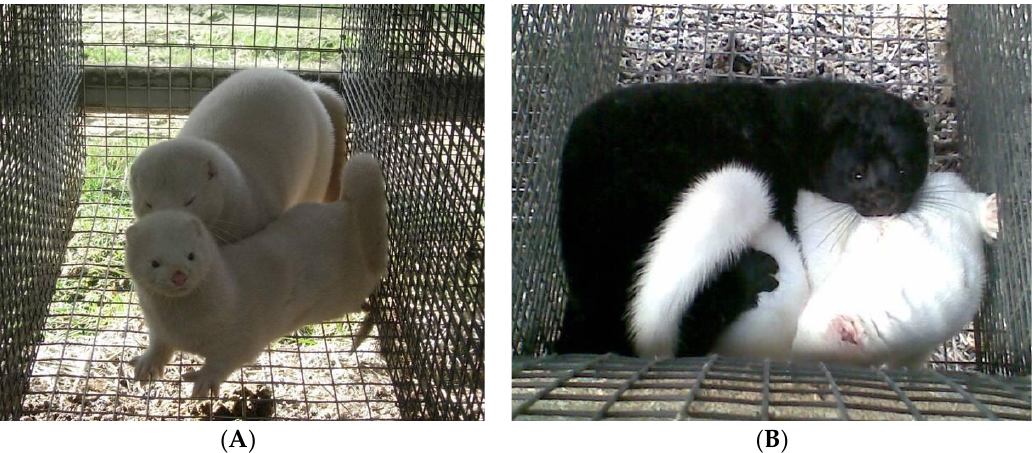
Figure 1. A female in a male ’ s cage ( A ), Trying to mount a female ( B ) (A.